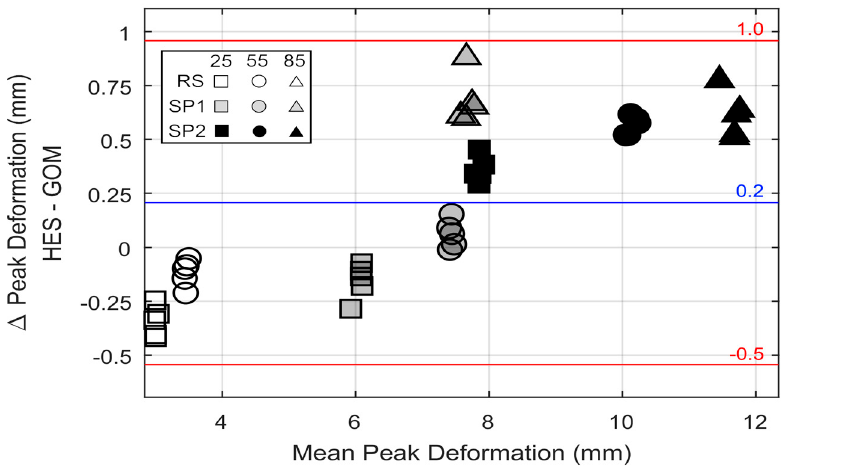
Figure 5. Bland–Altman plot comparing the peak vertical deformation values from the Hall effect sensor (HES) and GOM gold standard measurement. The horizontal blue line represents the mean difference and the red lines the upper and lower quartiles (95% confidence intervals).